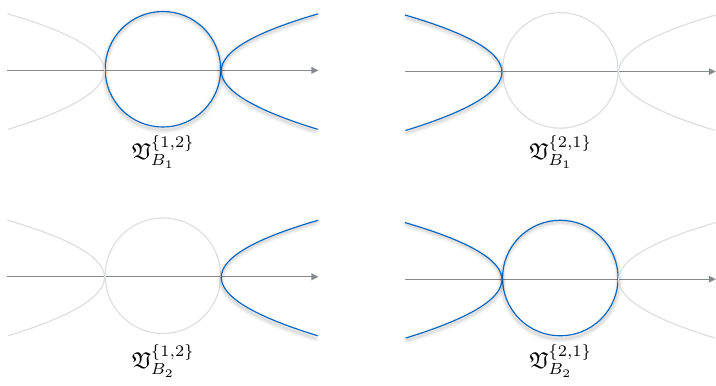
1 and v 2 for permu-